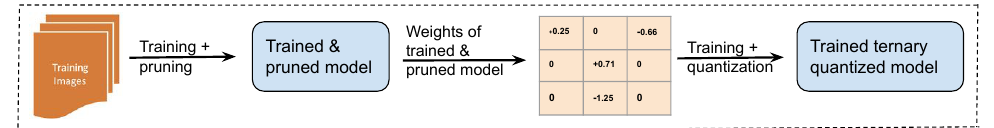
Figure 2. Design flow used to obtain a quantized DNN containing ternary weights.